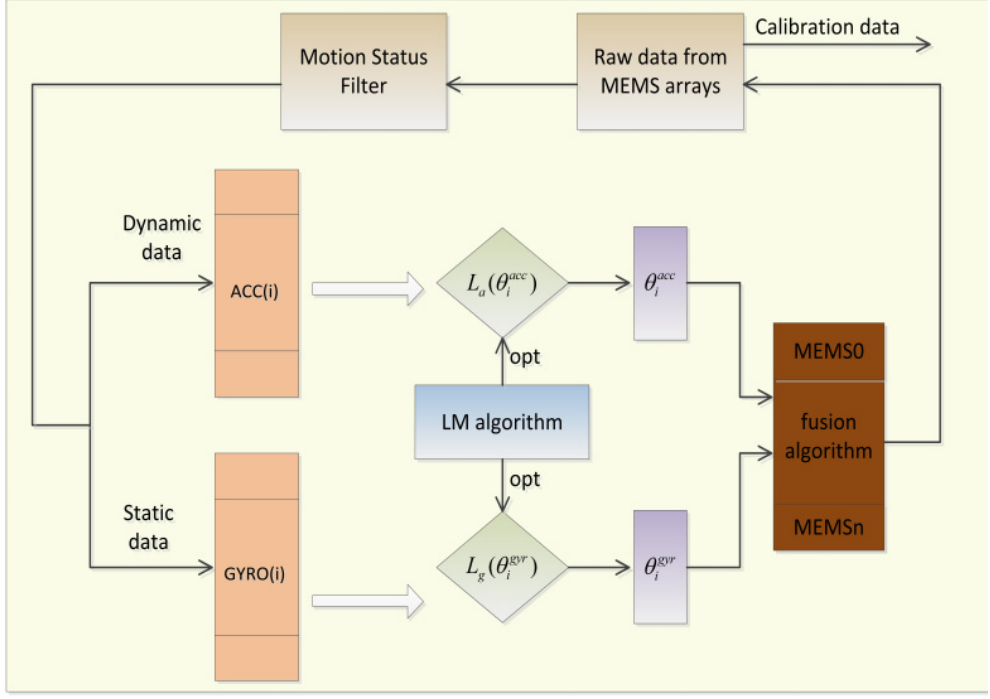
Figure 5. Flow chart of the overall calibration.